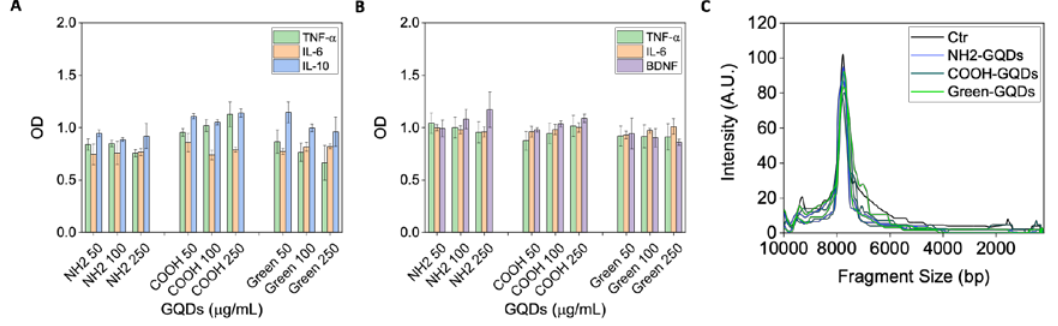
Figure 3. Effect of GQDs on secretion of cytokines, as reported in the relative legend, for U87 ( A ) and cortical neurons ( B ). Data are expressed as the mean normalized to the untreated control cells ± standard deviation. Line profile of DNA fragmentation for U87 and cortical neurons ( C ).